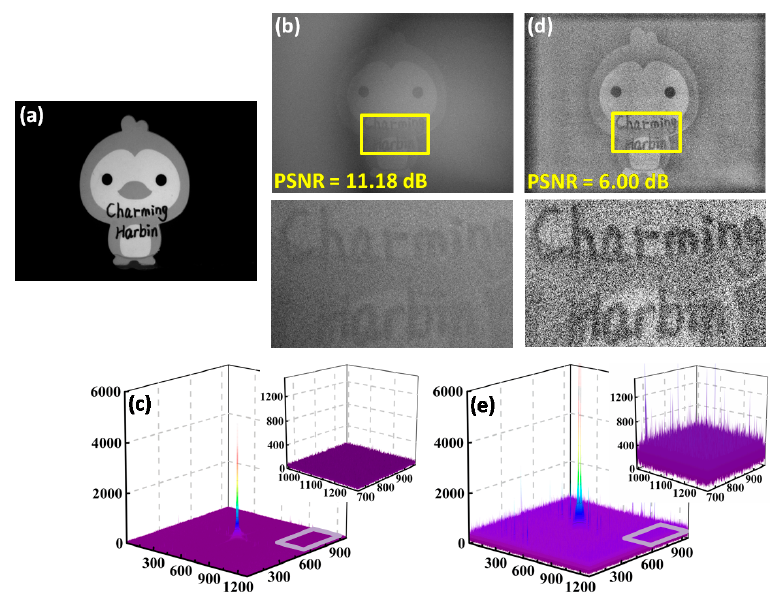
Figure 6. ( a ) is the target image in clear water; ( b ) is the result of Li’s method [25]; ( c ) is the spatial S obtained by our method; ( e ) is the spatial frequency spec- frequency spectrum of ( b ); ( d ) is the pro 1 trum of ( d